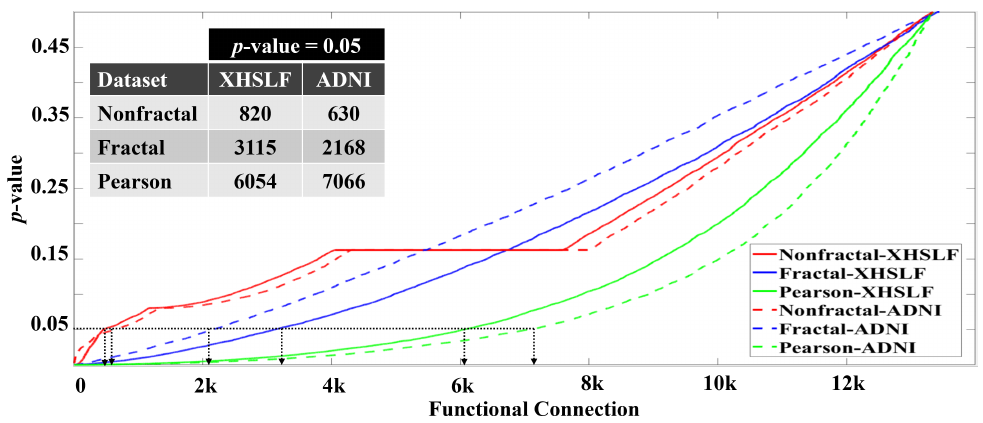
Figure 5. Plot of p -value of 13,456 connections of XHSLF and ADNI datasets arranged in increasing order for nonfractal, fractal and Pearson correlation. The number of significant connections, obtained at p = 0.05, for each connectivity measure is listed in the inset